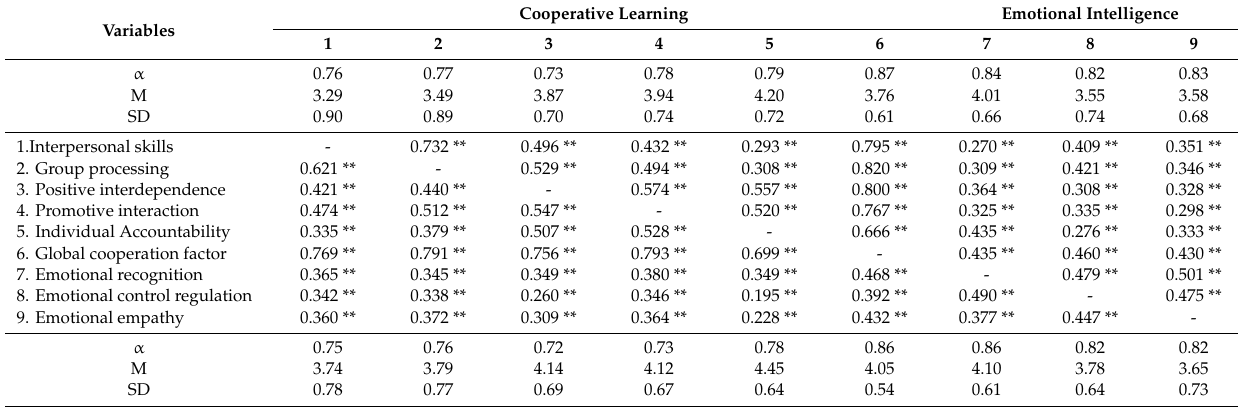
Table 1. Alphas, means, standard deviations and bivariate correlations of the observed variables in primary school (below) and secondary school (above) students. Variables